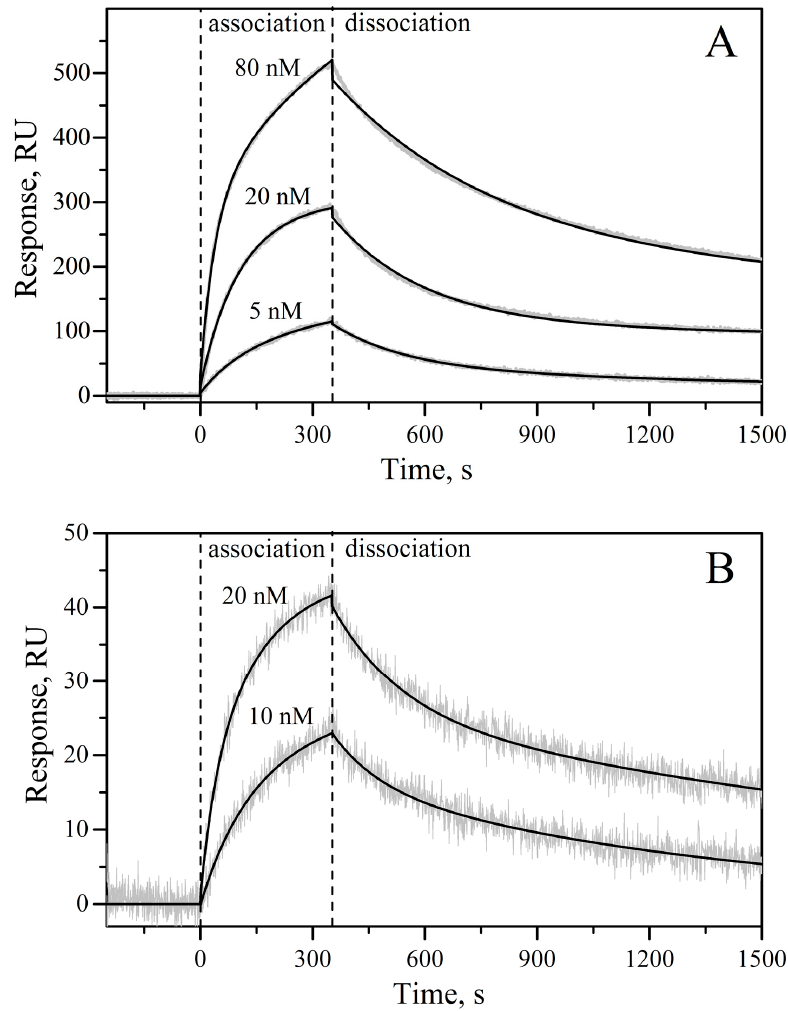
Figure 5. Kinetics of the interaction of macaque/murine rIL-11 with sIL-11R α (panels A and B , respectively) at 25 °C, monitored by SPR spectroscopy (PBS, 0.05% TWEEN 20, pH 7.4 buffer). The biotinylated rIL-11 was immobilized on the surface of NLC sensor chip. Concentrations of sIL-11R α used as an analyte are indicated above the curves. Grey curves are experimental, while black curves are theoretical, calculated according to the heterogeneous ligand model (1) (see Table 1 for the fitting parameters).